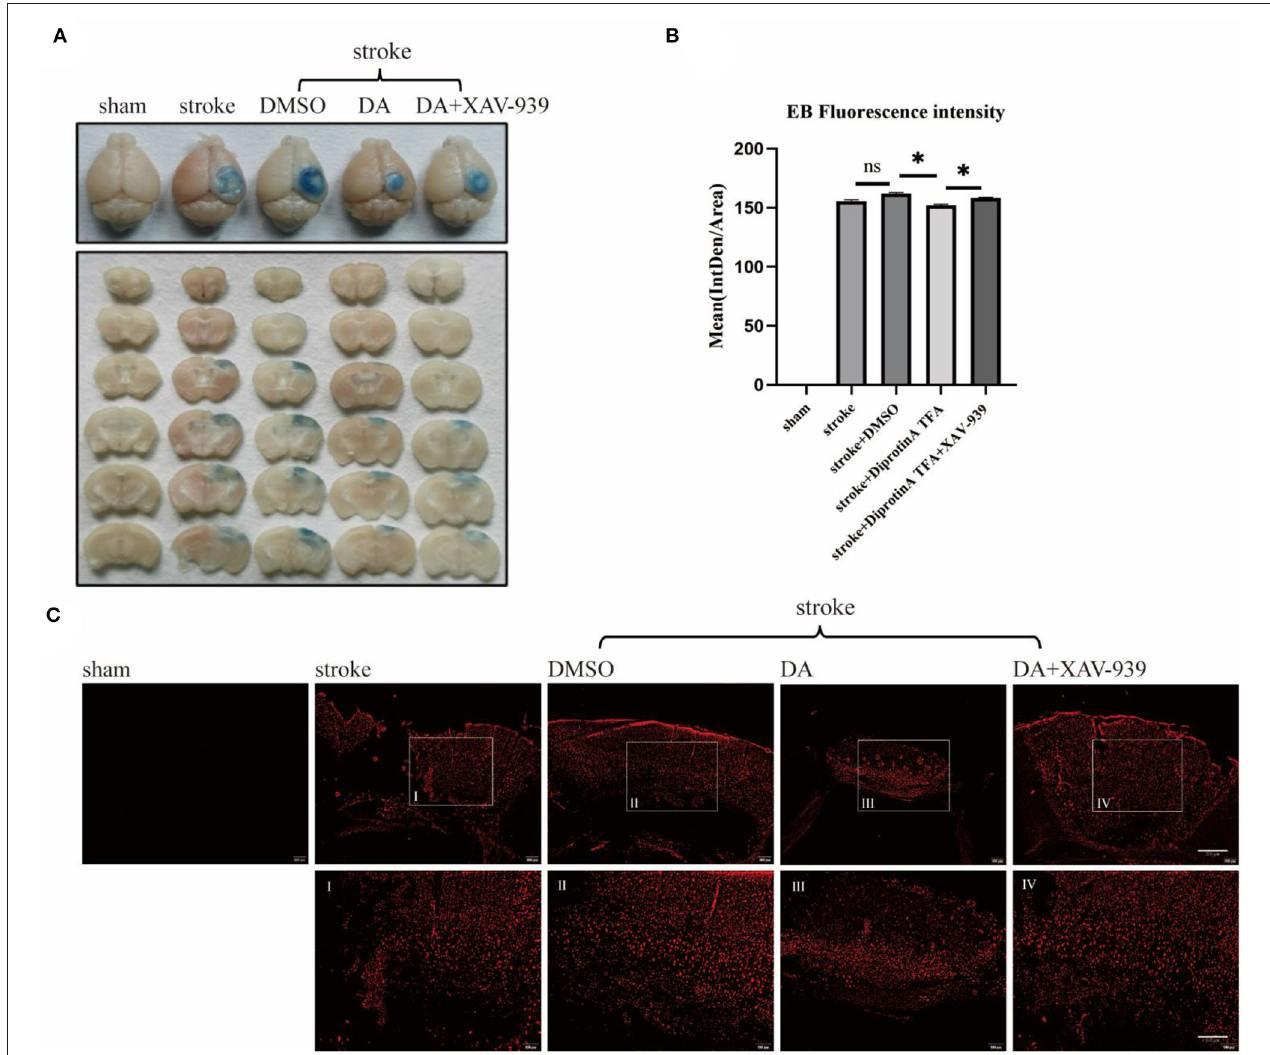
FIGURE 3 | Diprotin A TFA improves the permeability of the BBB after cerebral ischemic injury. (A) To inject 2% EB into the tail vein of five groups of mice to observe the extravasation of EB. (B) The mean fluorescence intensity of EB extravasation in the cerebral infarction area of the five groups of mice was statistically analyzed. n = 3 per group. Data are represented as mean with SEM. * p < 0.05. (C) Mice were injected with 2% EB into the tail vein, and the brains were perfused to obtain brain sections for immunofluorescence analysis. The slice thickness is 40 µ m. Bar = 200 µ m [ (C) , upper], bar = 100 µ m [ (C) , bottom]. BBB, blood-brain barrier; EB, Evans